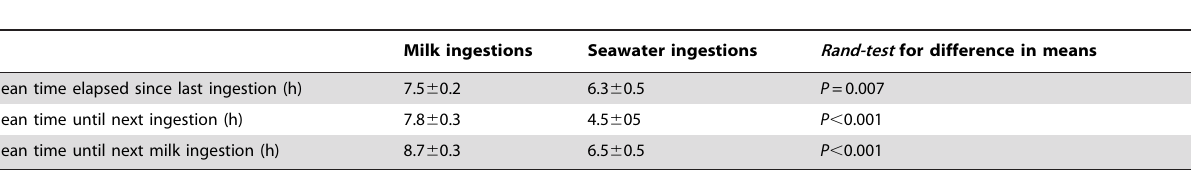
Milk ingestions Seawater